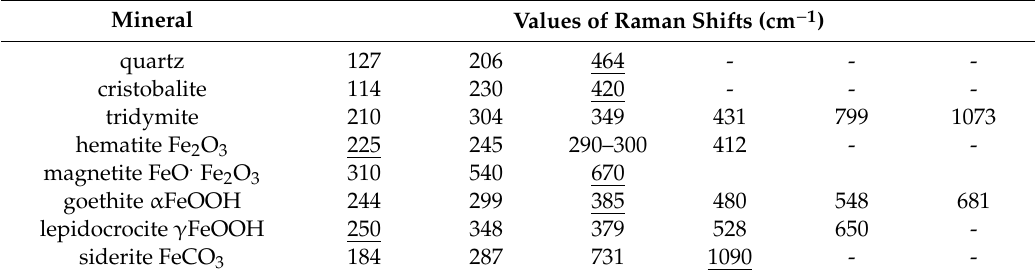
Table 3. Values of Raman shifts defined as diagnostic for the given